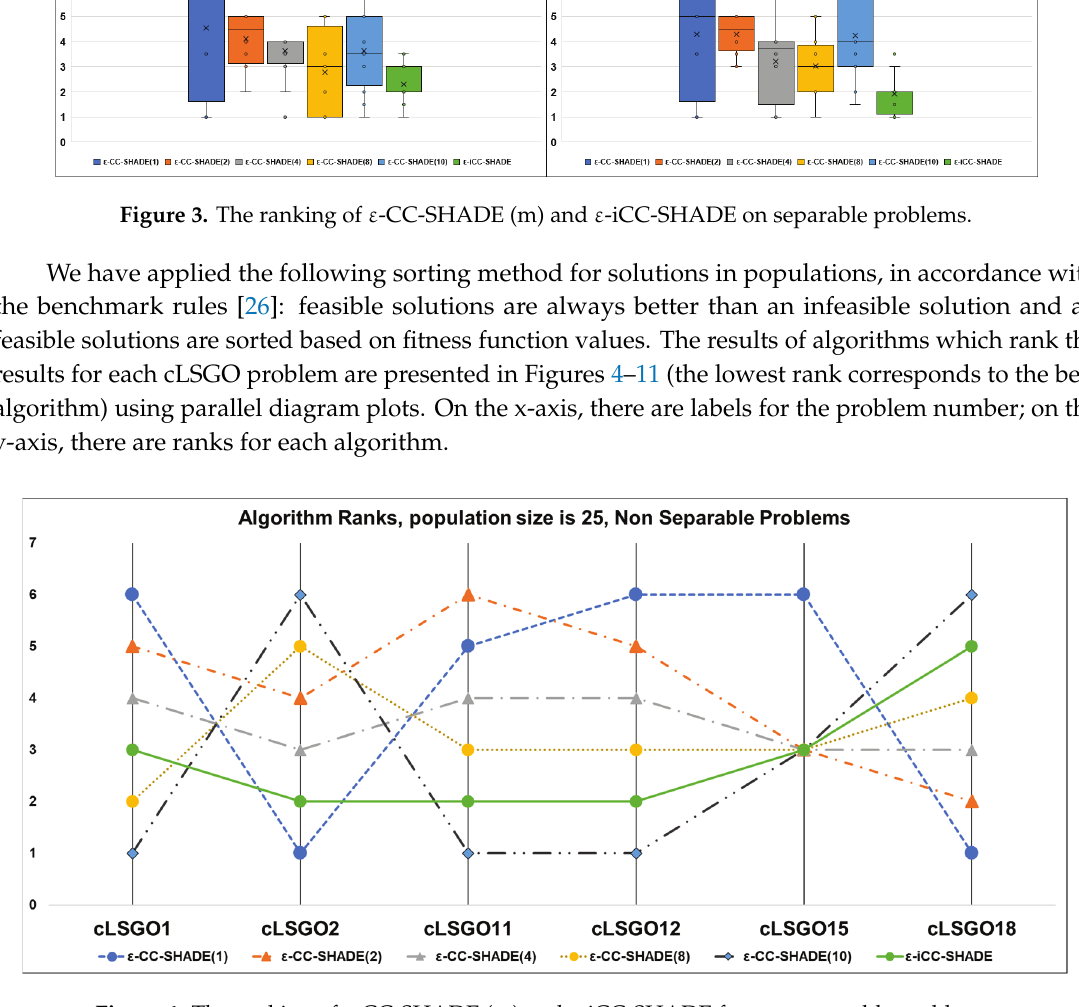
Figure 4. The ranking of ε -CC-SHADE (m) and ε -iCC-SHADE for non-separable problems.